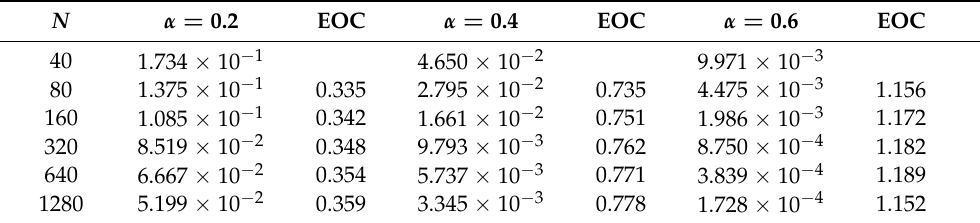
Table 9. Table showing the maximum absolute error and EOC for solving (27) using the rectangular method on a uniform mesh.